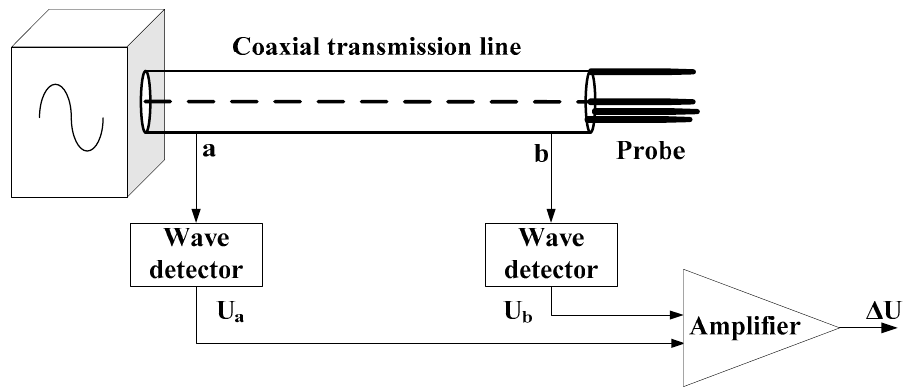
Figure 1. Diagram of the standing wave ratio (SWR) sensor and measurement circuit. U a and U b , output voltages of point a and point b on the coaxial transmission line, respectively; Δ U, differential output voltage of point a and point b.